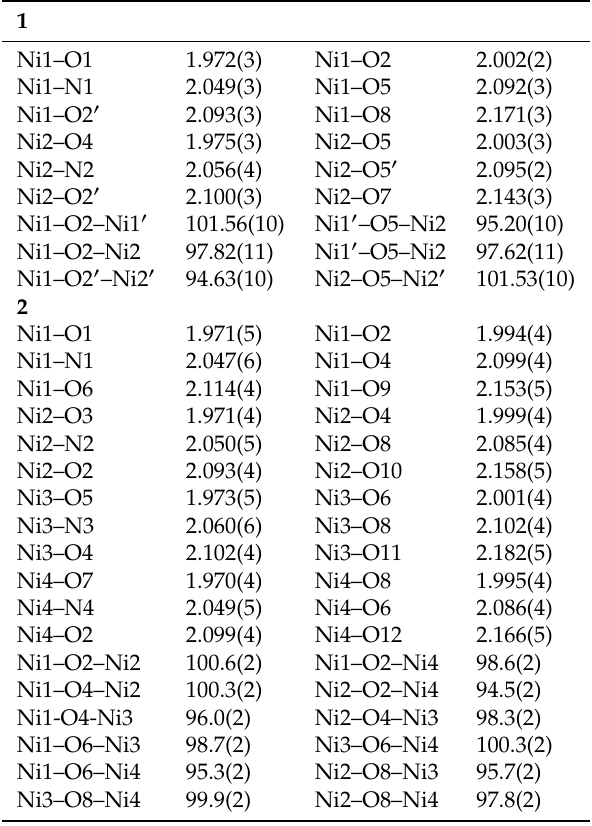
Table 2. Selected bond lengths (Å) and angles ( ◦ ) for complexes 1 and 2